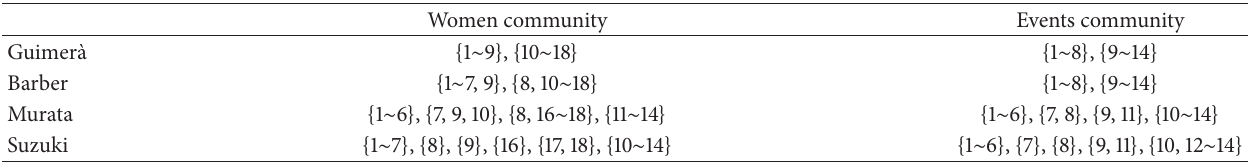
Table 4: Results of related algorithm.